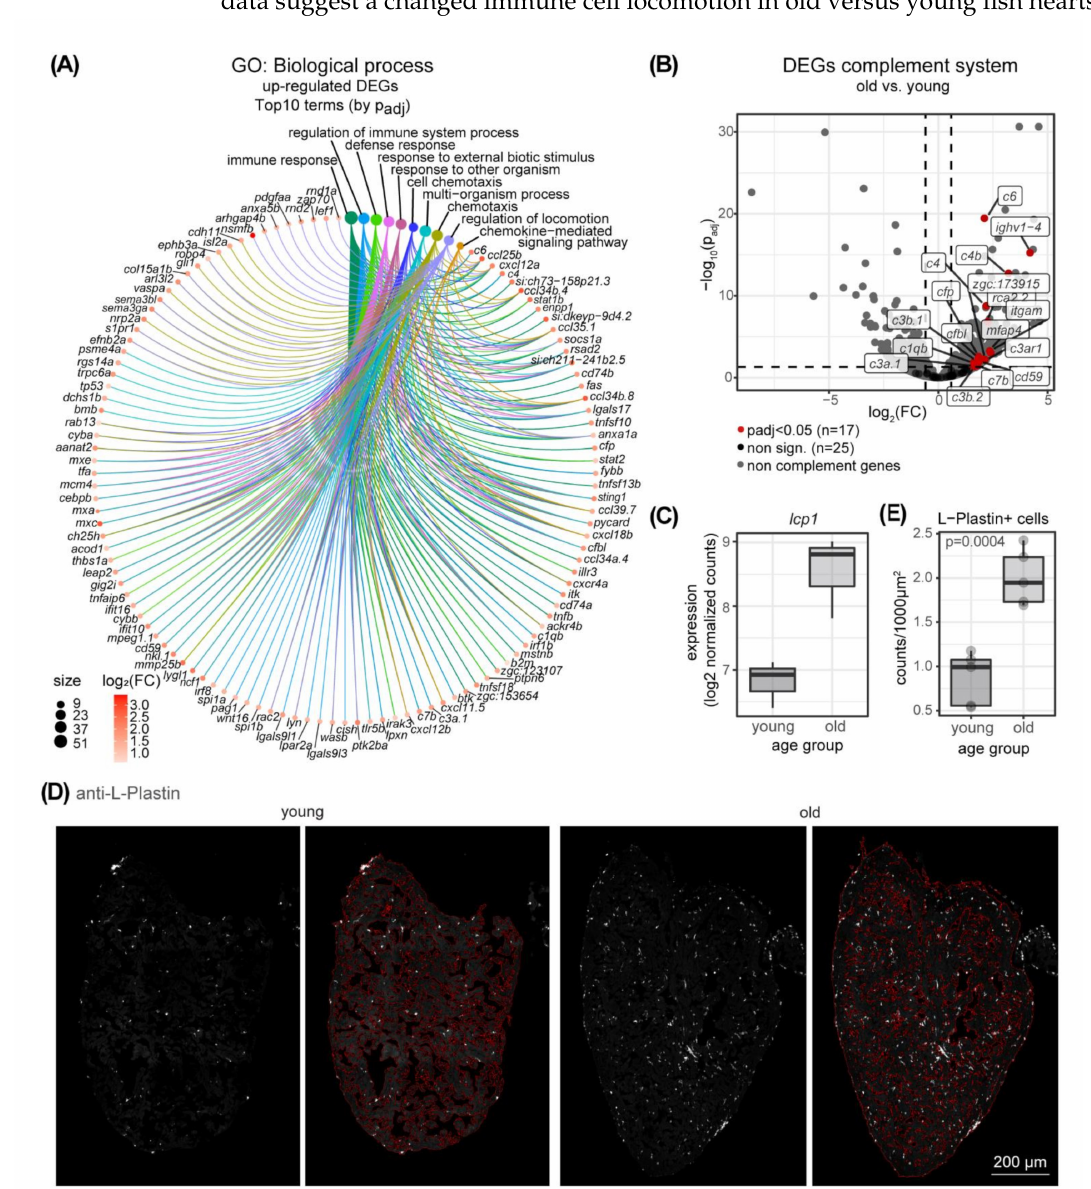
Figure 3. Expression of genes related to the immune system is changed upon aging. ( A ) Circular plot highlights the top 10 (by adjusted p -value) GO terms of the category “biological process” identified as enriched among 745 upregulated DEGs and the respective genes associated to these terms. The size of the GO term circle indicates the number of the genes and the color of the gene circle indicates the fold change (log 2 (FC)) in red shades. Immune system-related terms are prominent. ( B ) DEGs encoding components of the complement system are highlighted FC: fold change ( C ) Expression of the pan leukocyte marker gene lcp1 as log2 of normalized counts in young and old ventricles. n = 3. ( D ) Immunostaining of heart sections of old (37 months) and young (8 months) fish for the pan-leukocyte marker L-Plastin. The muscle tissue area that was segmented using ZEN Intellesis, is indicated in red in the respective right panels. Scale bar is 200 µ m. ( E ) Quantification of L-Plastin- positive cells (from ( D )) as counts per 1000 µ m 2 muscle area. n = 5; two-sample t -test p =